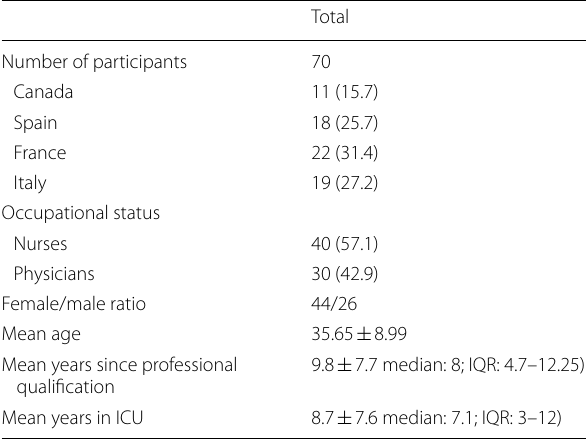
Data represents n (%) or means